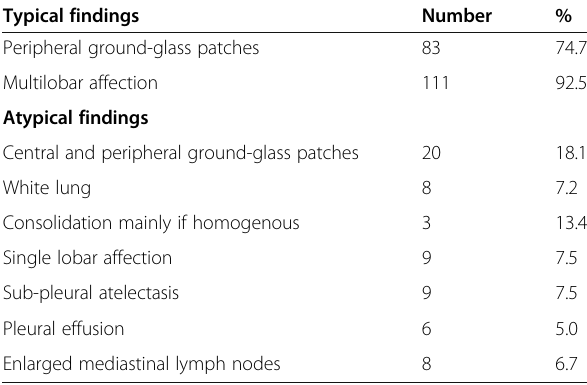
Table 2 Association between outcome with age and the significant clinical